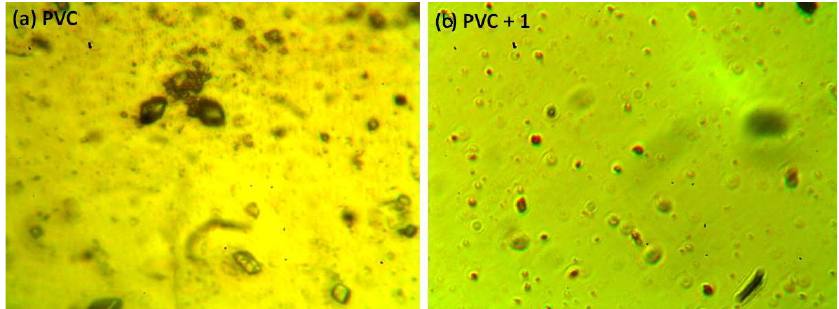
Figure 9. Optical microscopic images of the ( a ) blank PVC film and ( b ) PVC + compound 1 film before irradiation.